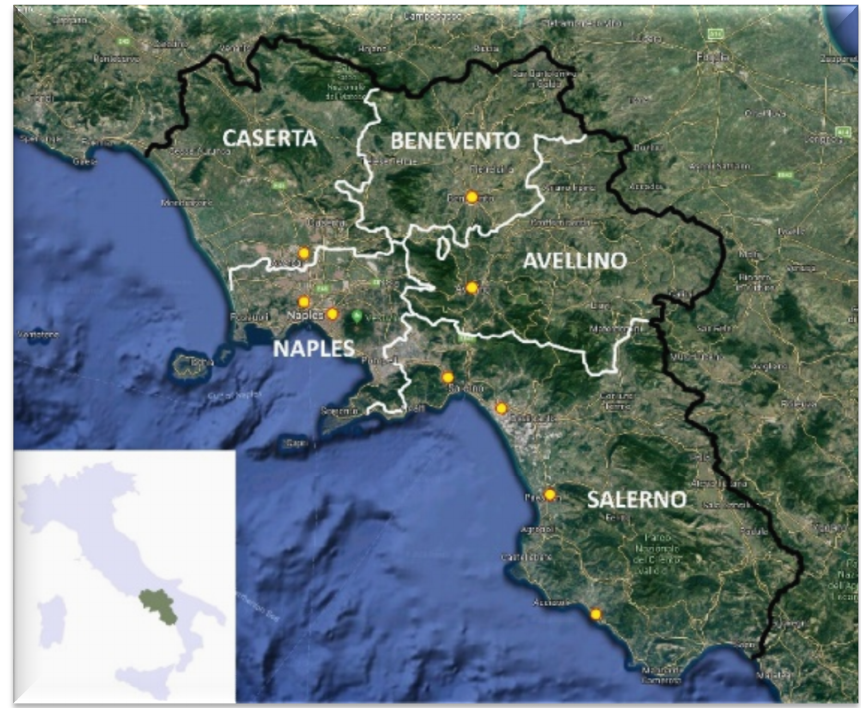
Figure 1. Key urban agricultural and EGI-oriented projects labeled (i.e., yellow points) within the provinces of the Campania region, Italy. Source: Google Earth.